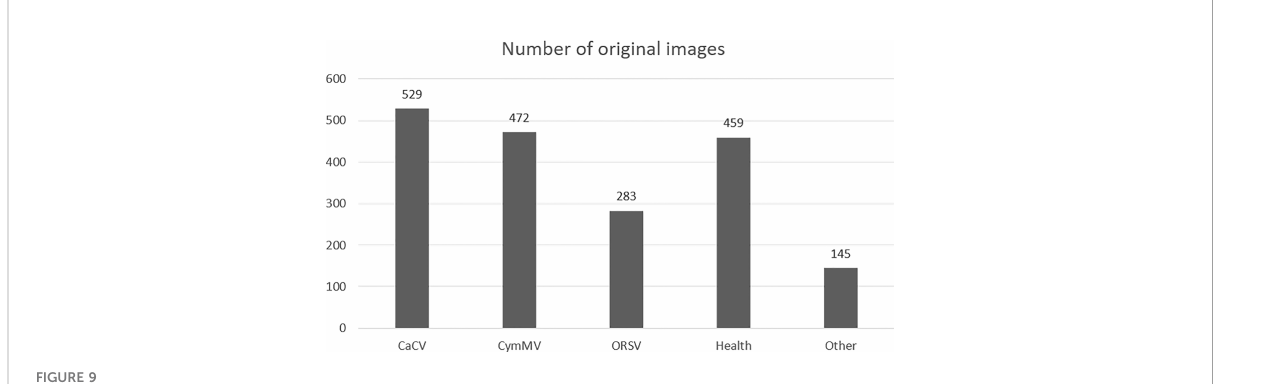
FIGURE 9 The number of collected orchid images with different